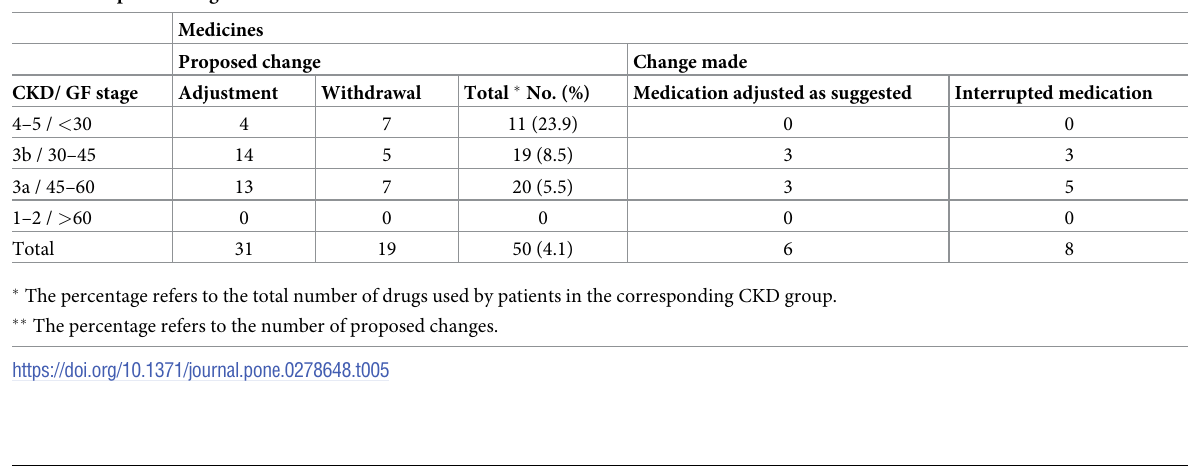
Table 4 lists all medicines that were requested for dose adjustment or withdrawal, and what was eventually done. The detail broken down by CKD stage can be seen in Table 5. Table 6 lists the 6 medications with dose adjustment and the patient’s characteristics. Table 7 lists the 8 medications that were discontinued and the patient’s characteristics.